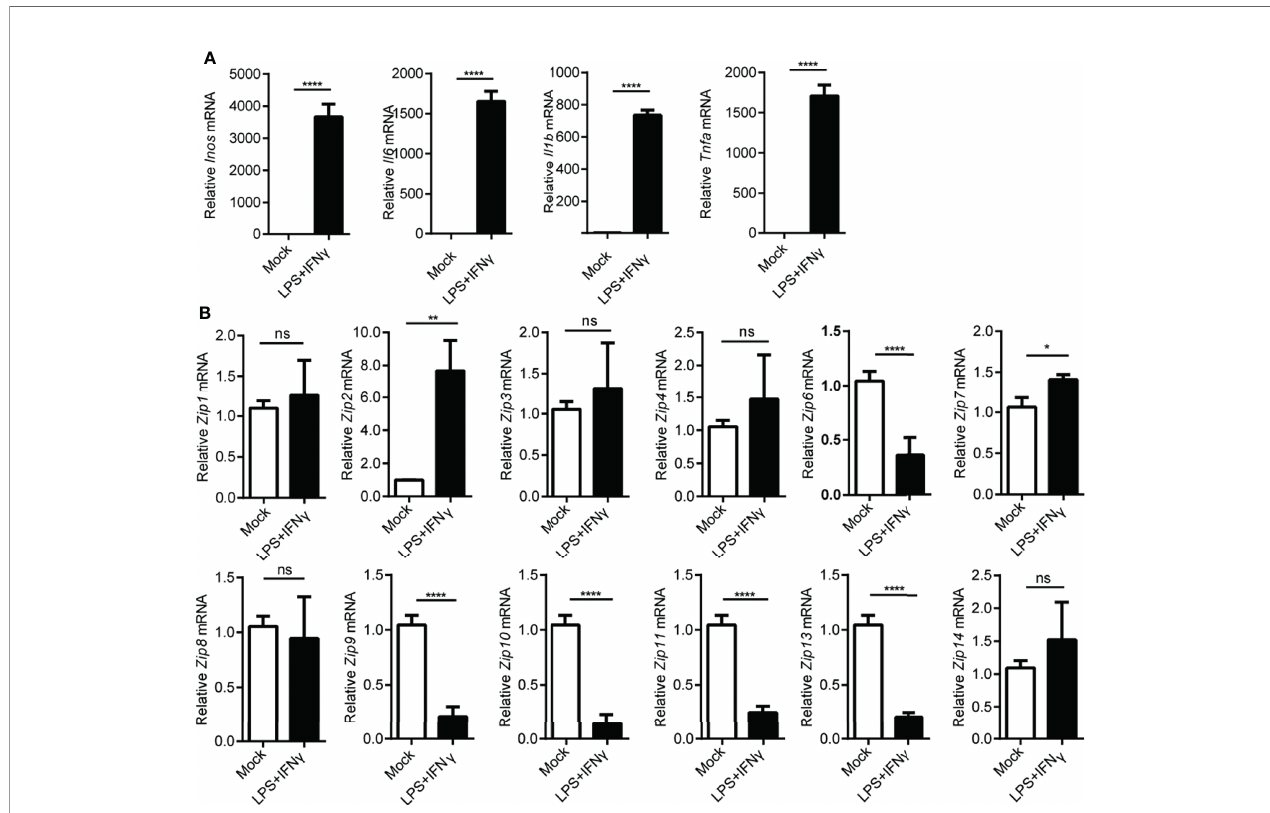
FIGURE 4 | Transcription of Zip9 is downregulated during M1 macrophage polarity. (A) M1 macrophage characteristic genes were assessed by RT-PCR. M1 macrophages were generated by PEMs stimulating with LPS plus IFN g . Data were normalized for b -actin mRNA levels. Results were presented as the average ± SD of three independent experiments. (B) PEMs were stimulated with LPS plus IFN g for 6 h to measure Zips mRNA levels by RT-PCR. Results were presented as the average ± SD of three independent experiments. Data were normalized for b -actin mRNA levels. A, B was analyzed by Student ’ s t-test. The representative data from three independent experiments are shown. P values are as followed: * P < 0.05, ** P < 0.01, and **** P < 0.0001, ns, not signi fi